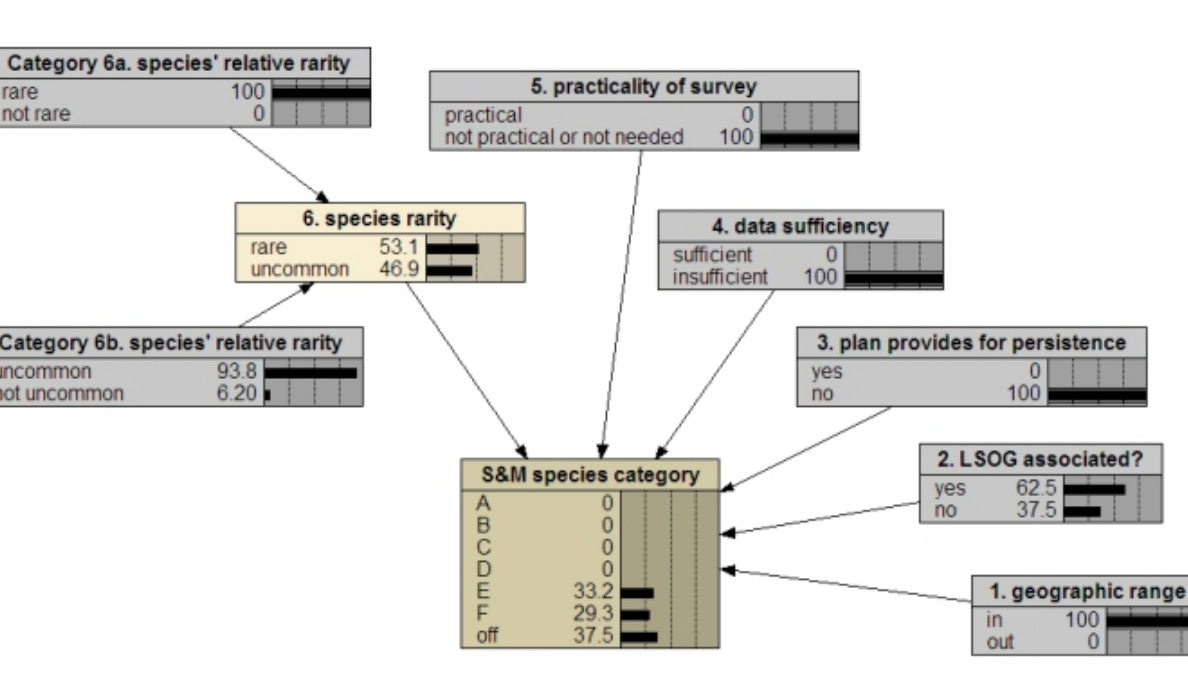
Fig. 1. Overall Bayesian belief network (BBN) decision model used by evaluation panels to guide their recommendations on appropriate conservation management categories of Survey and Manage (SM) species under the Northwest Forest Plan of federal agencies in Pacific Northwest, United States. The model displays potential species conservation management categories as a function of six evaluation categories. Figs. 1–8 are parameterized for a rare lichen, Fuscopannaria saubinetii, and gray boxes denote data provided by taxa